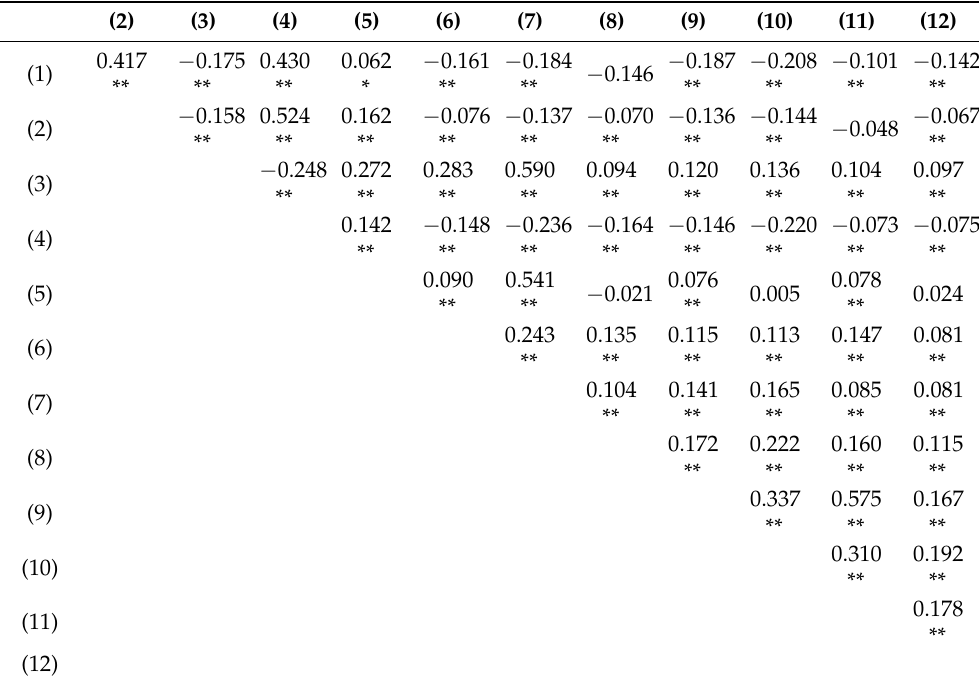
Table 2. Bivariate Correlations for Perceptions of Policing Practice and Level of Awareness Scales.